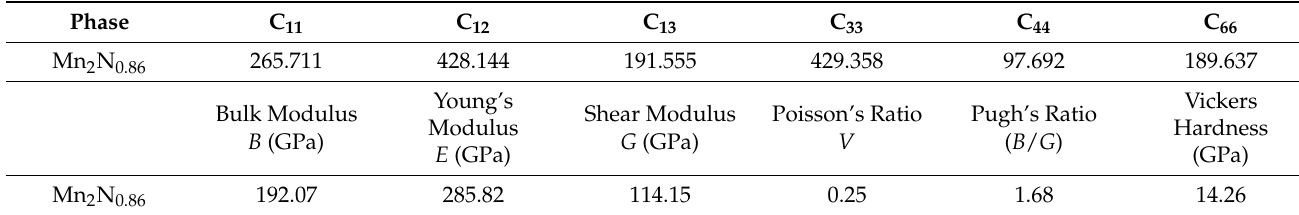
Table 2. The mechanic parameters of Mn 2 N 0.86